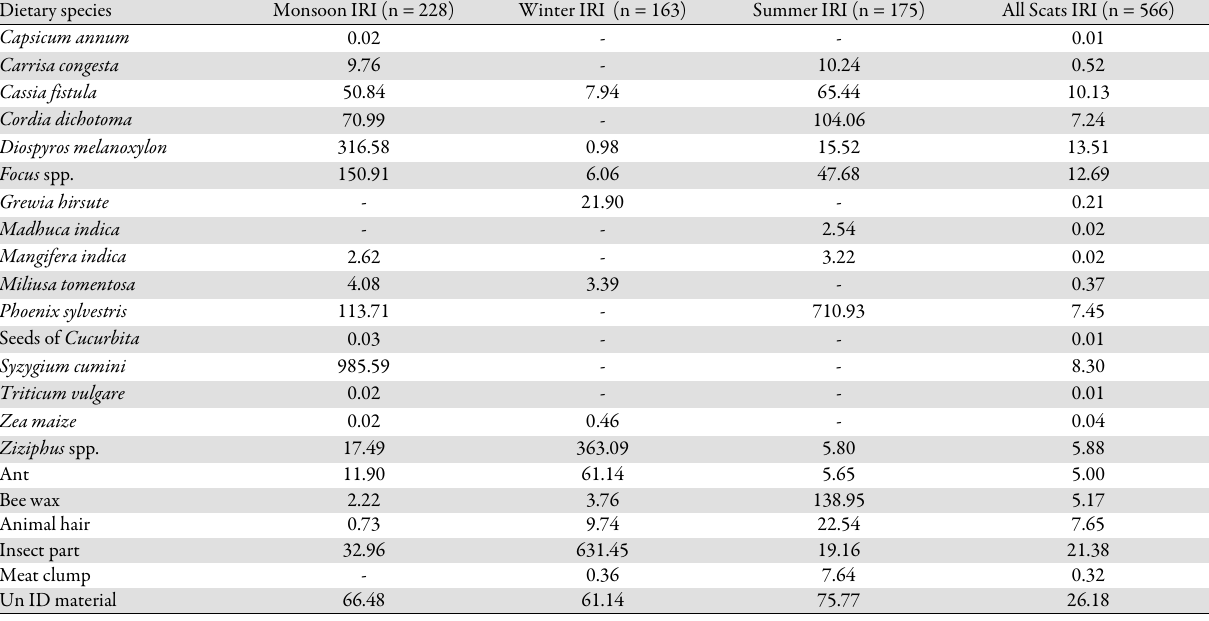
Table 2. Food habits of the Sloth bear ( Melursus ursinus ) in Banaskantha forests, Gujarat, in different seasons Dietary species